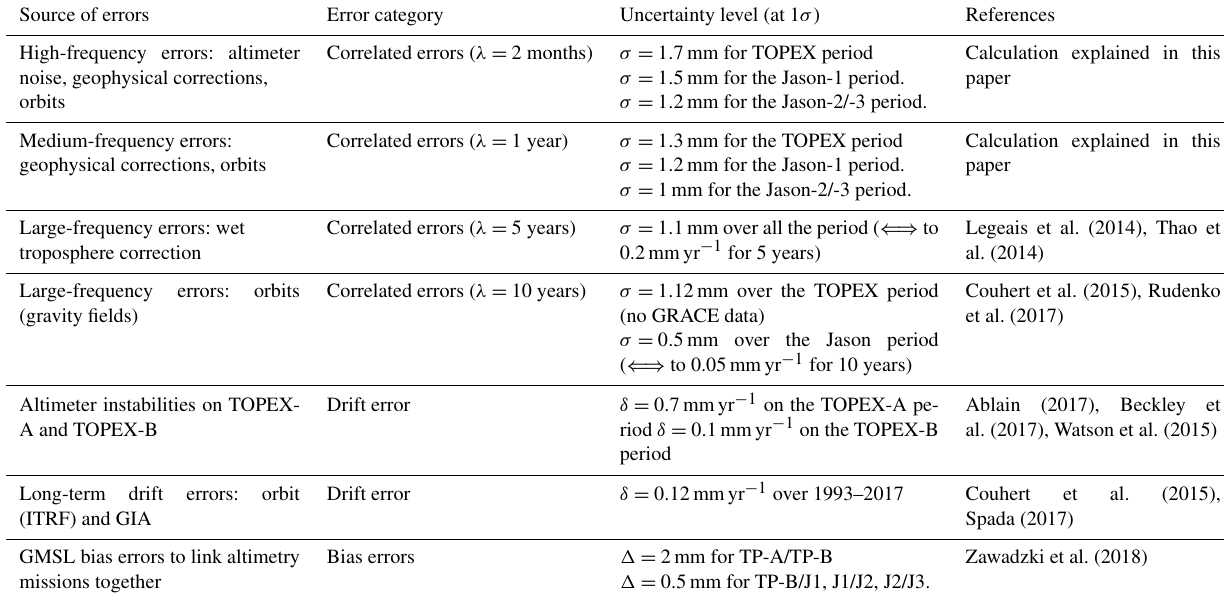
Table 1. Altimetry GMSL error budget given at 1 σ . Source of errors Error